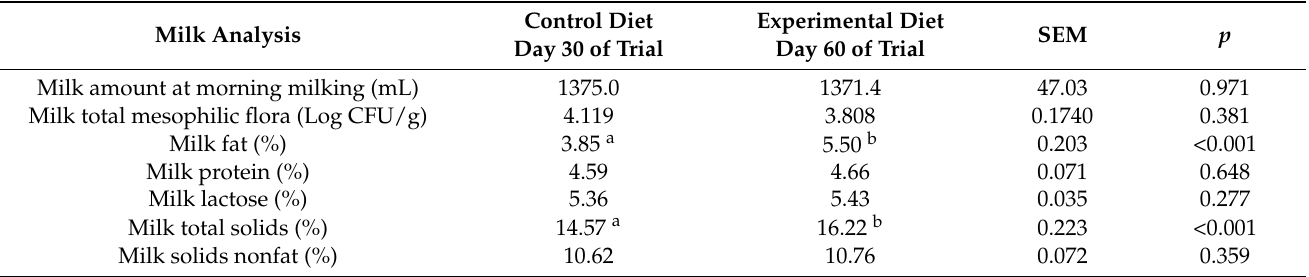
Table 2. Effect of dietary supplementation on ovine milk amount, total mesophilic microflora, and chemical composition.